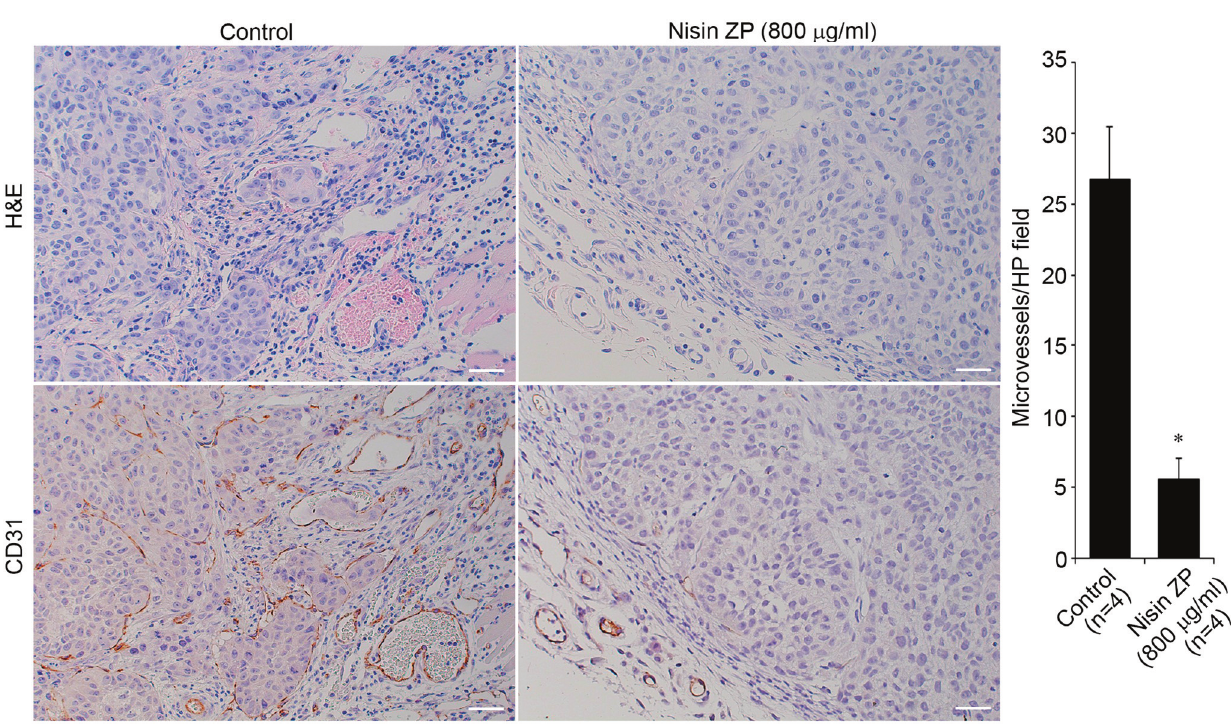
Fig 7. Nisin ZP reduces tumor microvessel density. A , Representative images of histological sections stained with H&E (top), and histological sections immunostained for CD31 (bottom) to identify blood vessels. B , Graph showing the results of microvessel quantification from five high power fields per tumor ( * p <